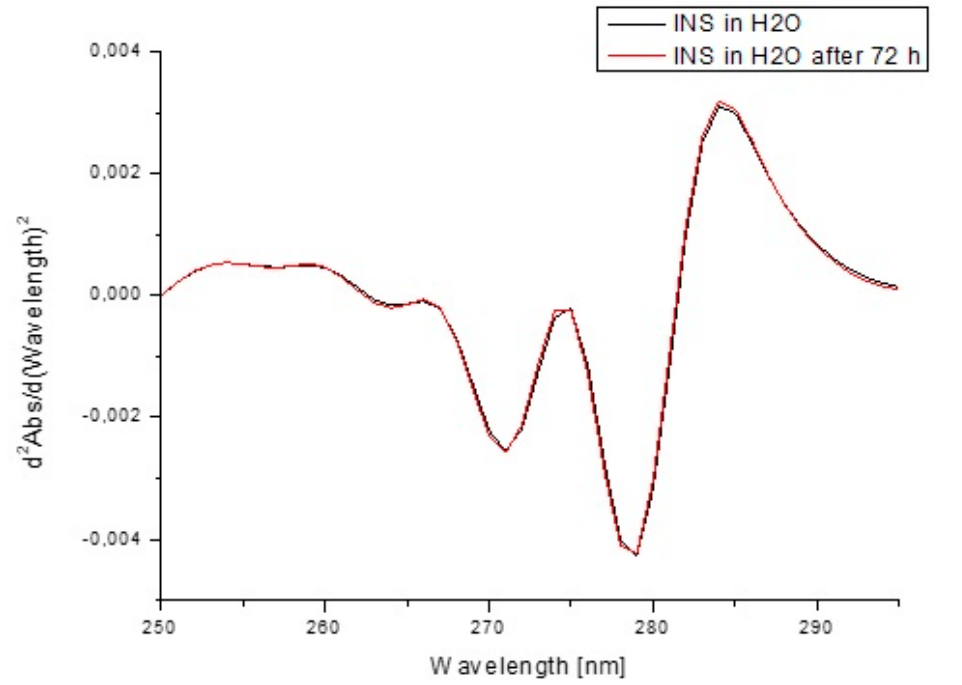
Figure 16. Second derivative absorption spectra of insulin at 1.04 × 10 − 5 g/cm 3 concentration both in H 2 O immediately after sample preparation and after 72 h.